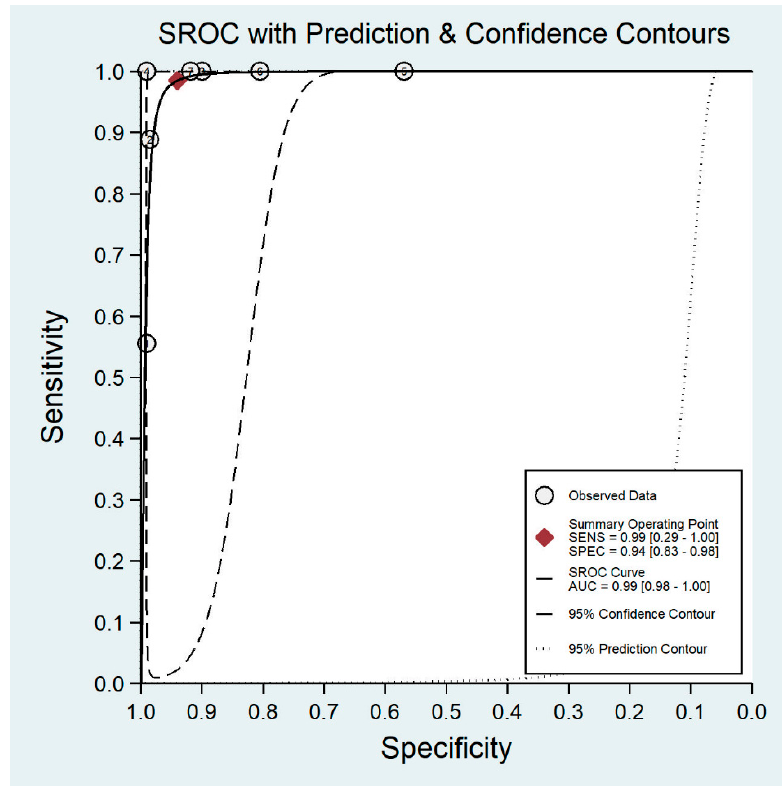
Figure 8. Receiver operating characteristic curve for smartphone-based imaging.